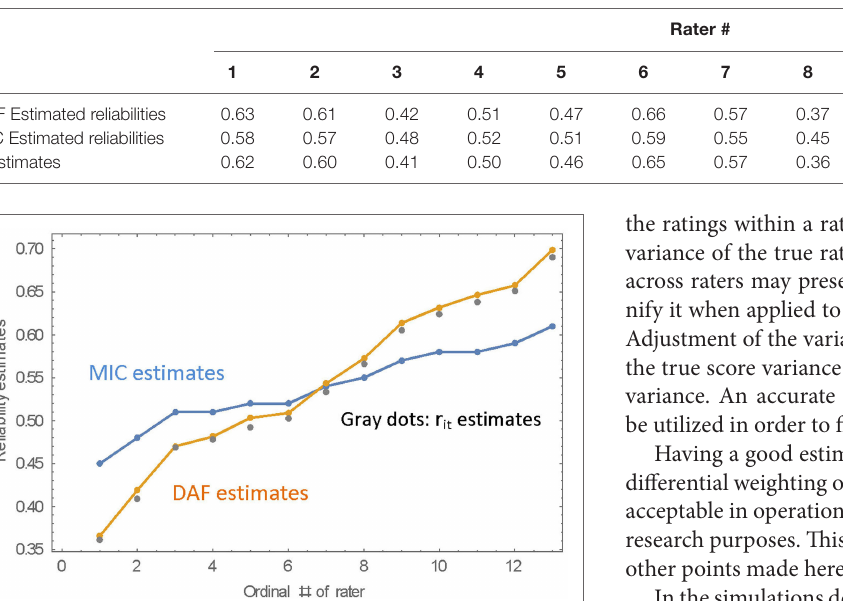
TaBle 8 | Reliability estimates for 13 raters.